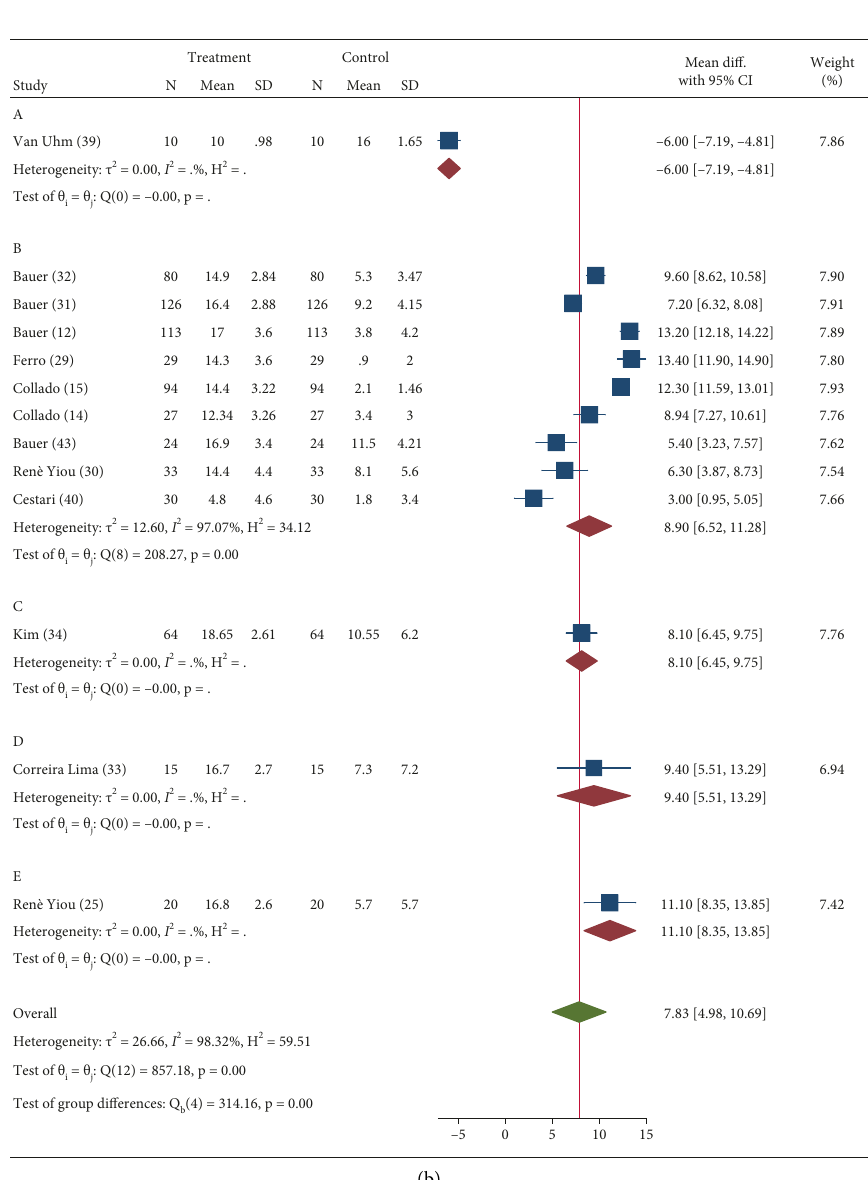
Figure 1: Forrest plot assessing standardized mean difference (SMD) for the number of pad/day (a) and ICIQ-SF score (b) recovery after device placement according to the five groups of invasive treatments for UI after RP, implemented within the studies included for analysis. ( A � bulking agents, B � fixed slings, C � adjustable slings, D � circumferential compressor device, and E � noncircumferential compressor devices; SD � standard deviation; CI � confidence